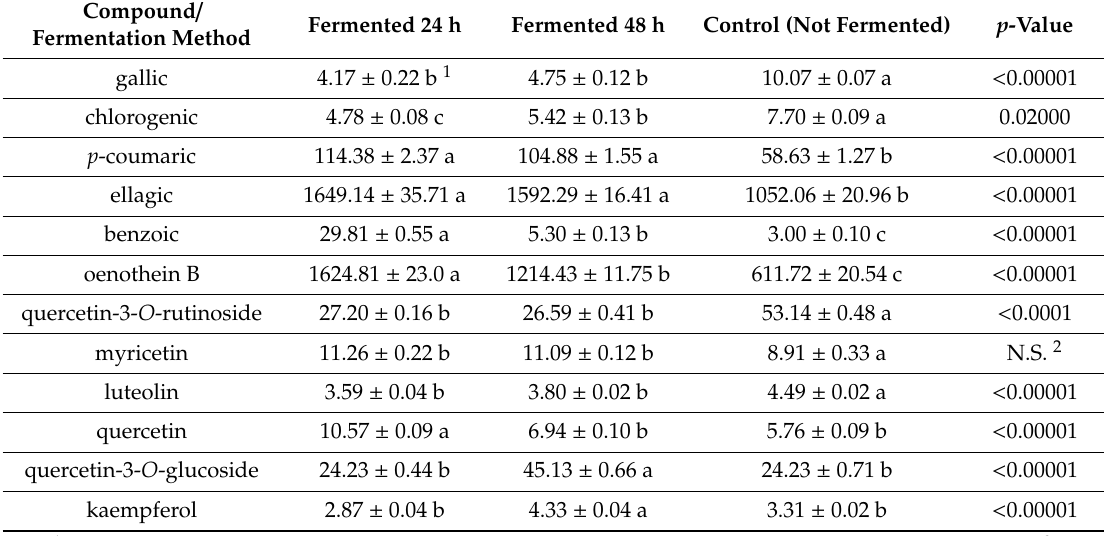
Table 2. The content of individual bioactive compounds (mg 100 g − 1 DW) in fireweed leaves in 2017. Mean value ± standard error, n = 3.